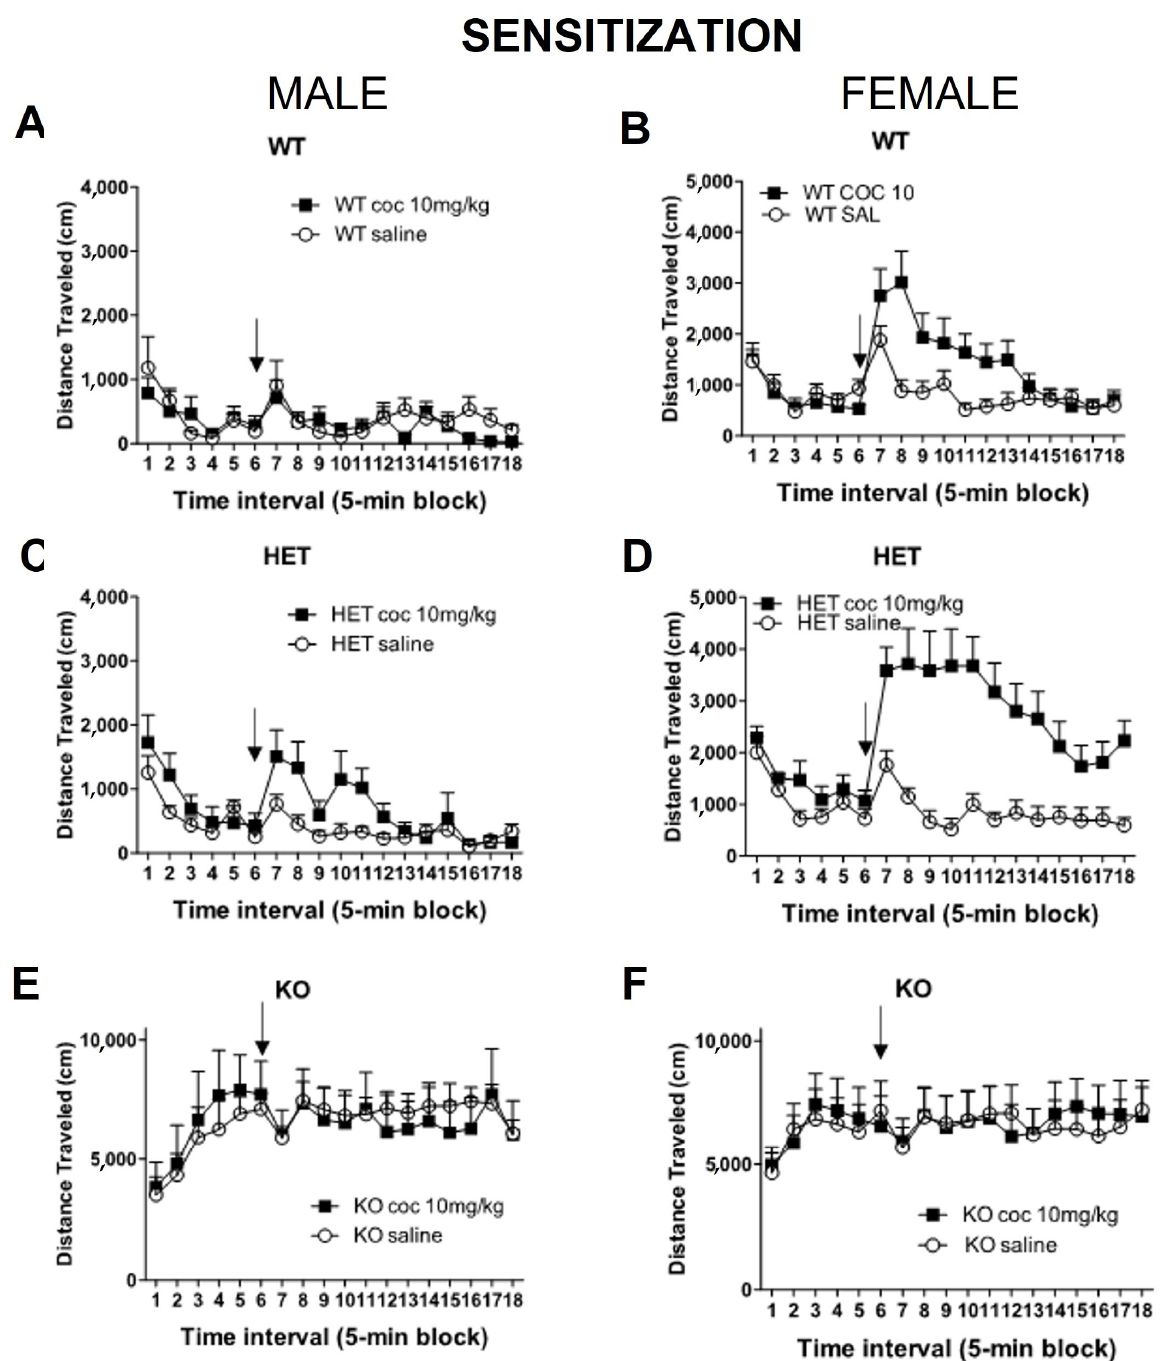
Figure 5. Effect of cocaine (sensitization challenge, 10 mg/kg) on locomotor activity in DAT mutant rats. At PND42, and after repeated daily cocaine injections in the home cage (PND36 to PND41), rats were left undisturbed in their home cages. At PND48, rats were habituated to the locomotor test chamber for 30 min. Cocaine (0 or 10 mg/kg) was injected (ip) and rats were returned to the chamber and monitored for 60 more min. Time course of locomotor activity of male ( A ) Wild-type (WT), ( C ) Heterozygous (HET) DAT rat and ( E ) Homozygous (KO) DAT Knockout rats, and female ( B ) Wild-type (WT), ( D ) Heterozygous (HET) DAT rat and ( F ) Homozygous (KO) DAT Knockout rats. Arrow indicates time of treatment. Mean ± SEM. (males: WT N = 15, HET N = 36, KO N = 17; females: WT N = 24, HET N = 24, KO N = 23).